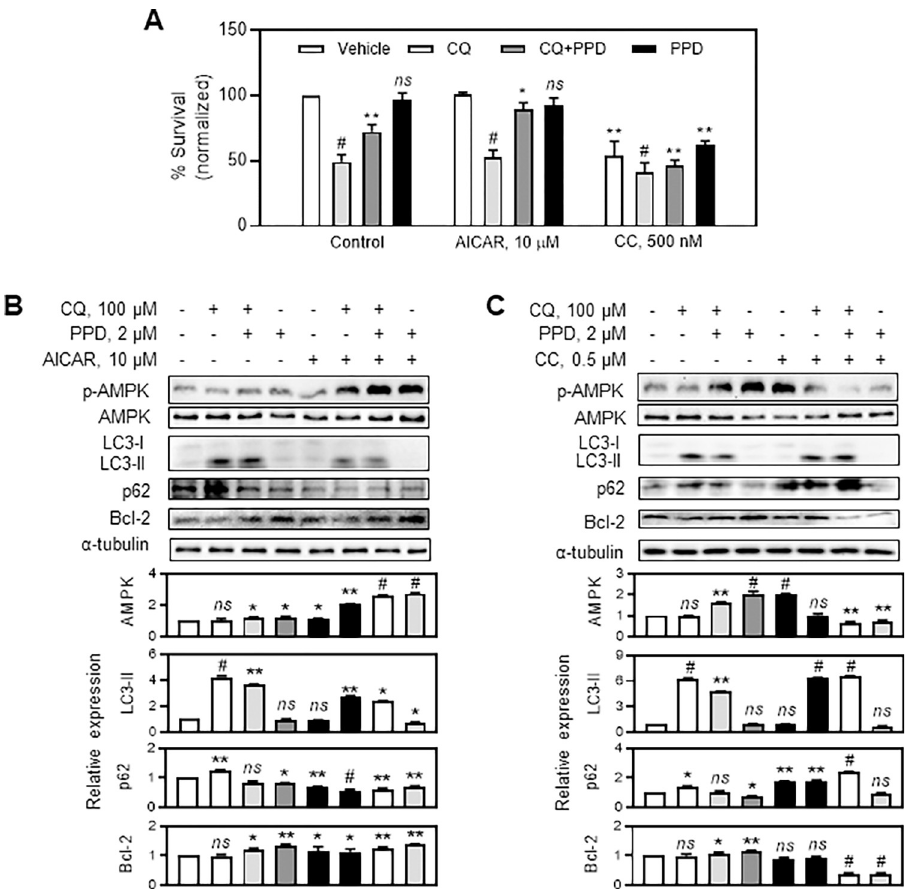
Fig 7. Modulation of AMP-activated protein kinase (AMPK)-induced alteration of protopanaxadiol (PPD) effects on chloroquine (CQ)-treated adult retinal pigment epithelial (ARPE)-19 cells. (A) Relative survival rate of ARPE- 19 cells treated with vehicle, 100 μ M CQ, CQ+PPD, and 2 μ M PPD with vehicle, 10 μ M AICAR, or 500 nM Compound C for 24 h. Cytotoxicity was assessed using 3-(4,5-dimethyl-thiazol-2-yl)-2,5-diphenyltetrazolium bromide (MTT) assay. (B, C) Western blotting (WB) and quantitative analysis of phosphorylated (p)-AMPK, AMPK, light chain 3 (LC3) I/II, p62, and B-cell lymphoma 2 (Bcl-2). Cells were treated with various drug combinations as indicate in (A) for 6 h. Bars denote relative changes in each protein. Data are means ± standard deviation (SD), n = 3; ns , � P < 0.05, �� P < 0.01, and # P < 0.001 vs control vehicle.